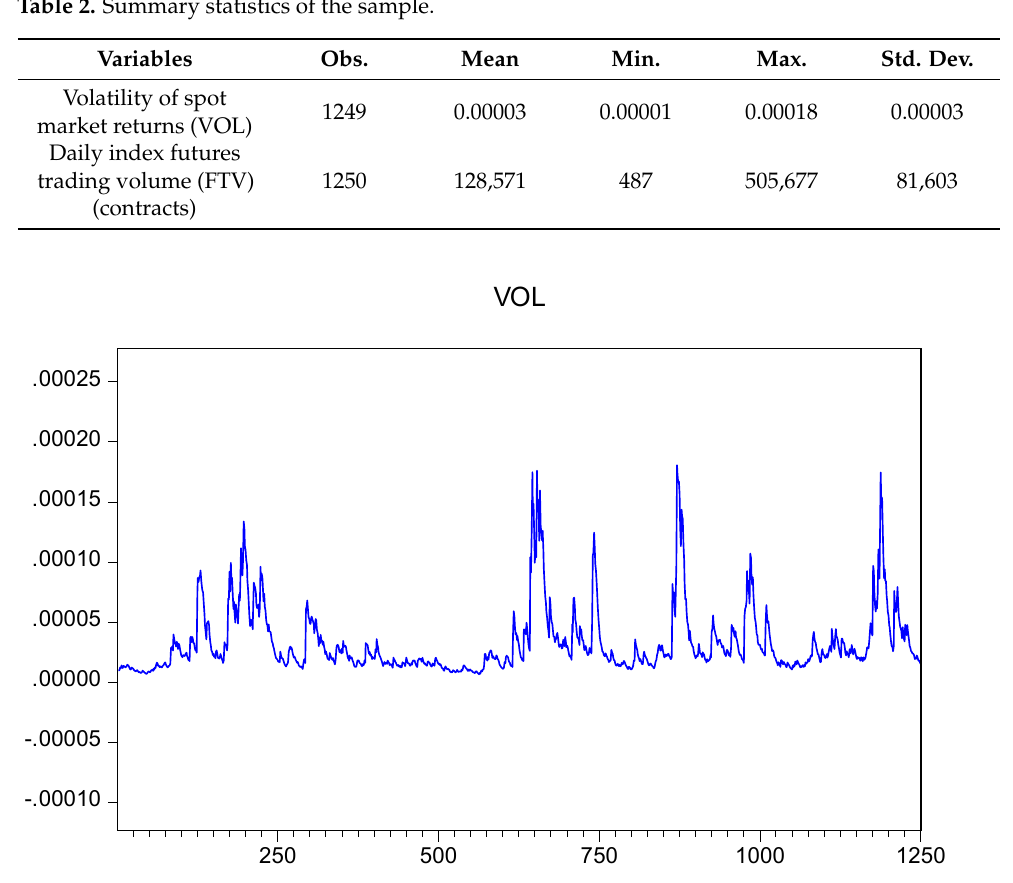
Figure 1. Volatility of spot market returns from 10 August 2017 to 10 August 2022.